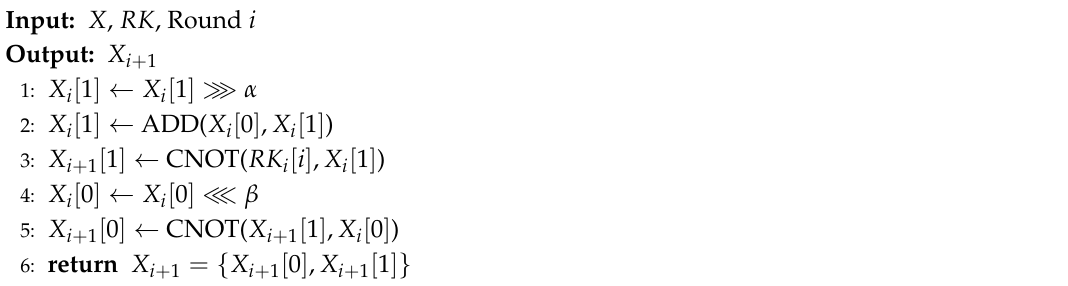
Algorithm 13 Round function of SPECK.